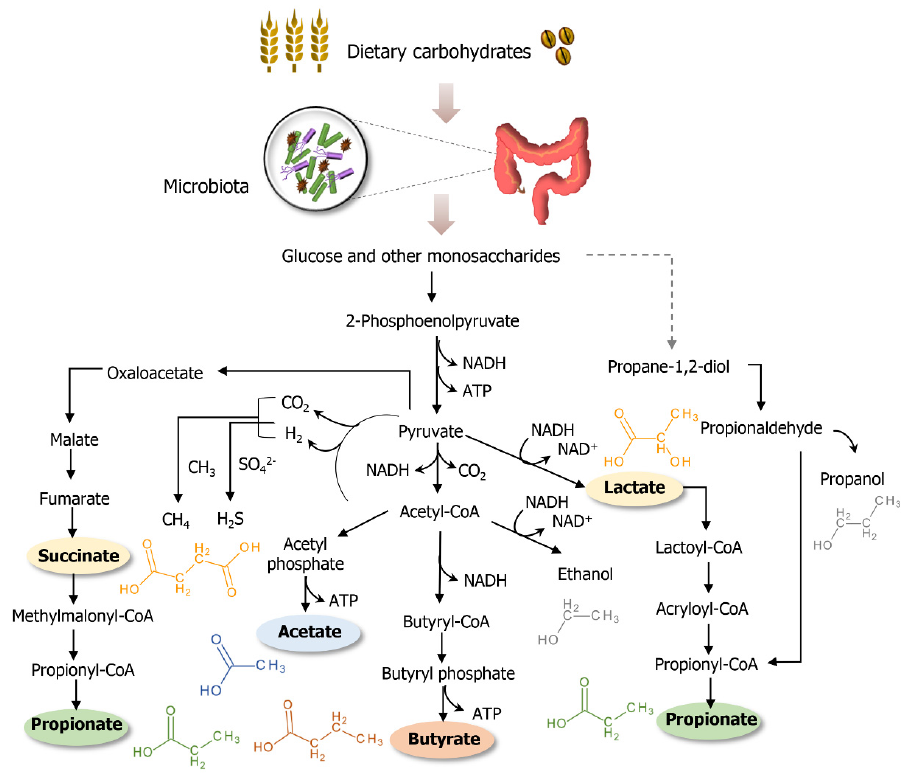
Figure 4. Bacterial fermentation pathways in the human gut. Based on Commane et al., 2005 [102] and Koh et al., 2016